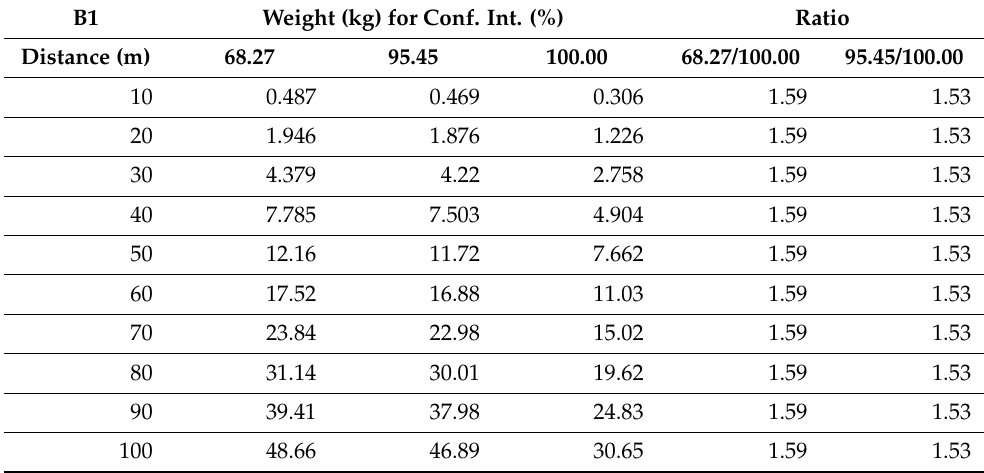
Table 4. Data from the calculated permissible charge weight per delay for the required distances from the blast, with the chosen maximum PPV for both confidence intervals (68.27% and 95.45%) and the full dataset, and their correlation.